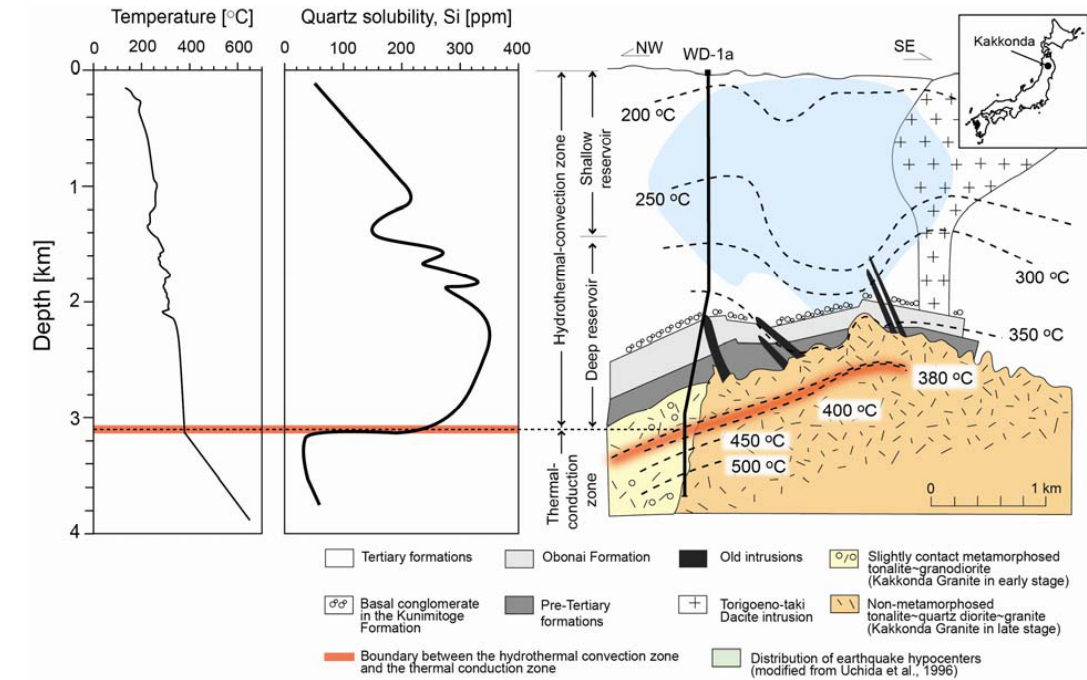
Figure 2. Location of the Kakkonda geothermal field in the Hachimantai volcanic field, northeastern Japan, and schematic cross section of the Kakkonda geothermal systems (modified after Doi et al., 1998). Well WD-1a encountered the boundary between the hydrothermal- convection and heat-conduction zones at a depth of 3100m (Doi et al., 1998). This figure will be published by Saishu et al.